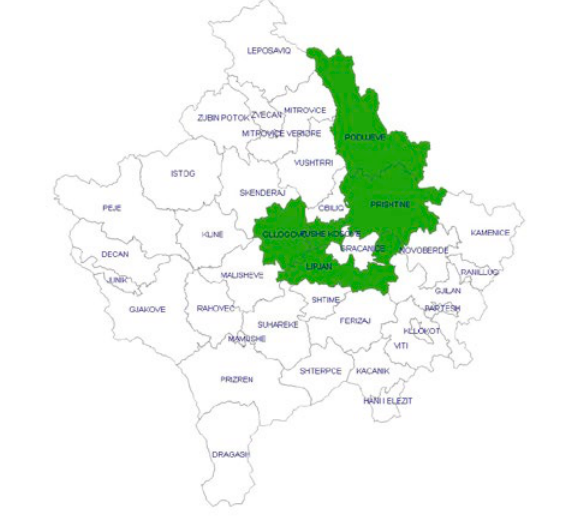
Figure 1. Sampling localization (loc.): 1) Prishtina, 2) Podu - jeve, 3) Gllogovc, 4) Lipjan, and 5) Fushe